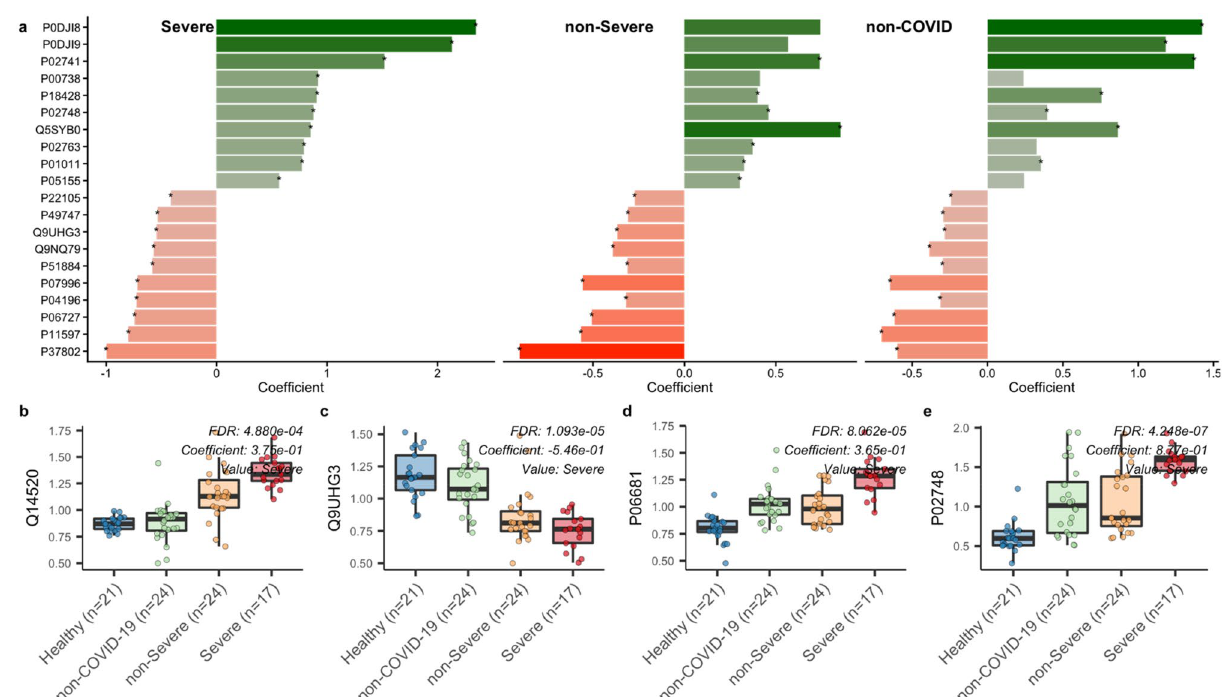
Figure 4. protein changes in COVID-19. ( a ) 20 most significant metabolites with lowest q-value (FDR) in comparison of severe group vs. healthy group are shown. Then, we show the corresponding changes in non- severe and non-COVID-19. ( b , c , d , e ) show different patterns we observed among these